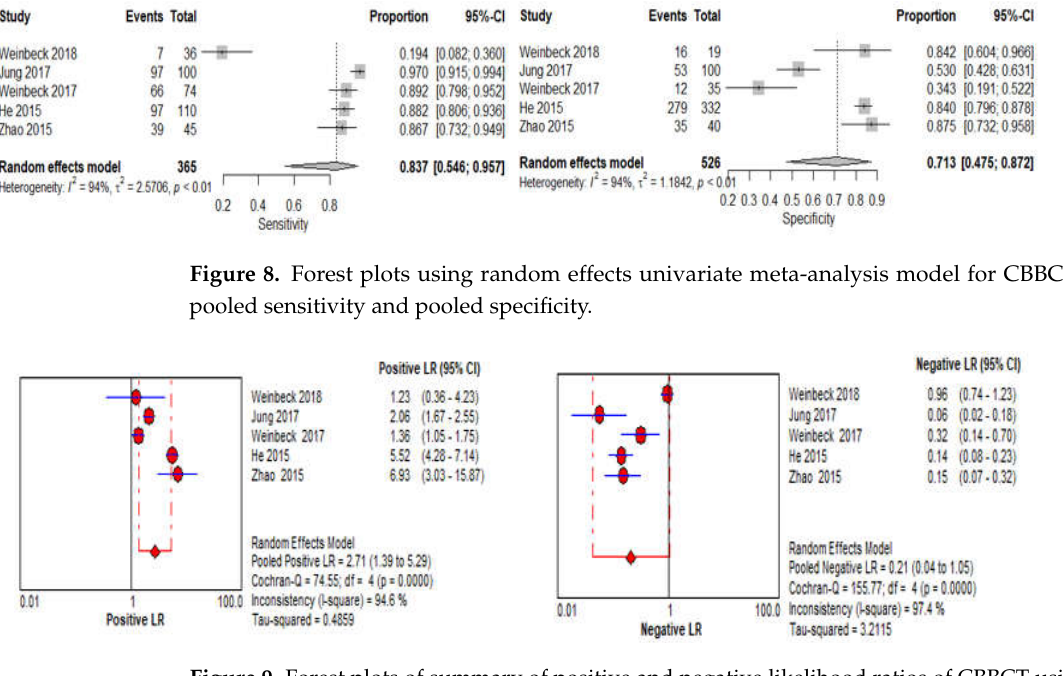
Figure 9. Forest plots of summary of positive and negative likelihood ratios of CBBCT using random effects bivariate model.